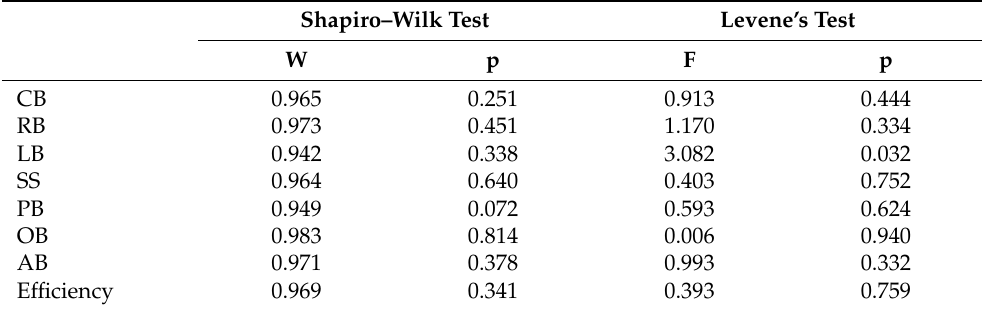
Table 3. Normality and homogeneity of variance values for dependent variables assessed by the 3 vs. 3 small-sided